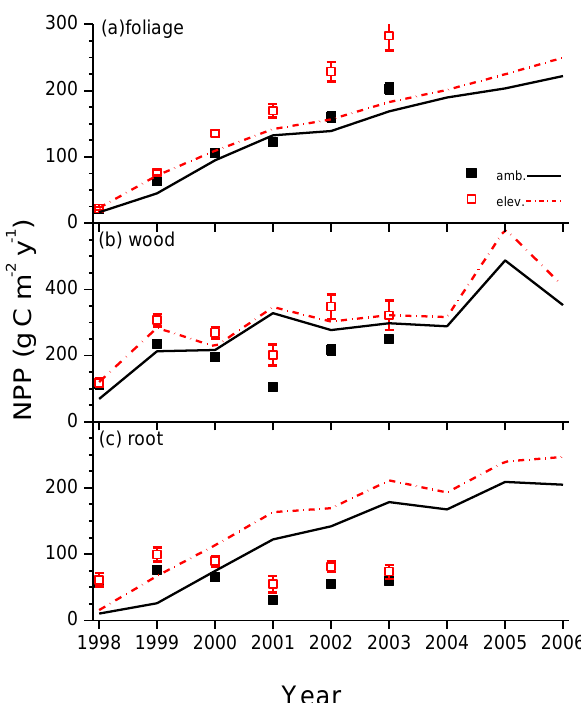
Fig. 11 Fig. 11. (a) Annual net primary productivity (NPP) measured (symbols) and modelled (lines) in (a) leaves, (b) wood and (c) roots 1998 to 2006 under ambient ( ∼ 374µmolmol − 1 ) vs. elevated ( ∼ 541µmolmol − 1 ) C a at the Rhinelander FACE experiment. Mea- sured data from King et al. (2005), with error bars representing stan- dard errors from replicated measurements ( n = 3). Root exudation (Grant, 1993) was excluded from modelled NPP to simulate bio- metric measurements.